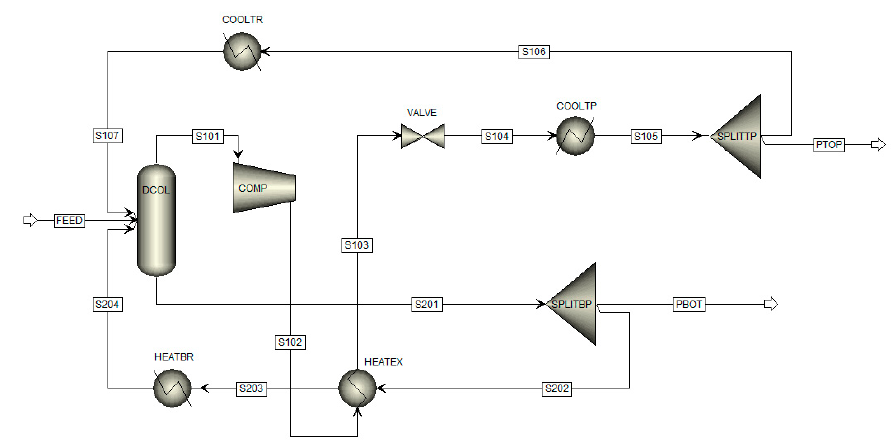
Figure 5. Schematic representation of the modified VRC model in Aspen Plus ® [51].